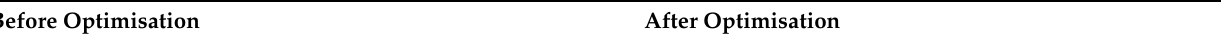
Table 21. Comparison of stress simulation results before and after